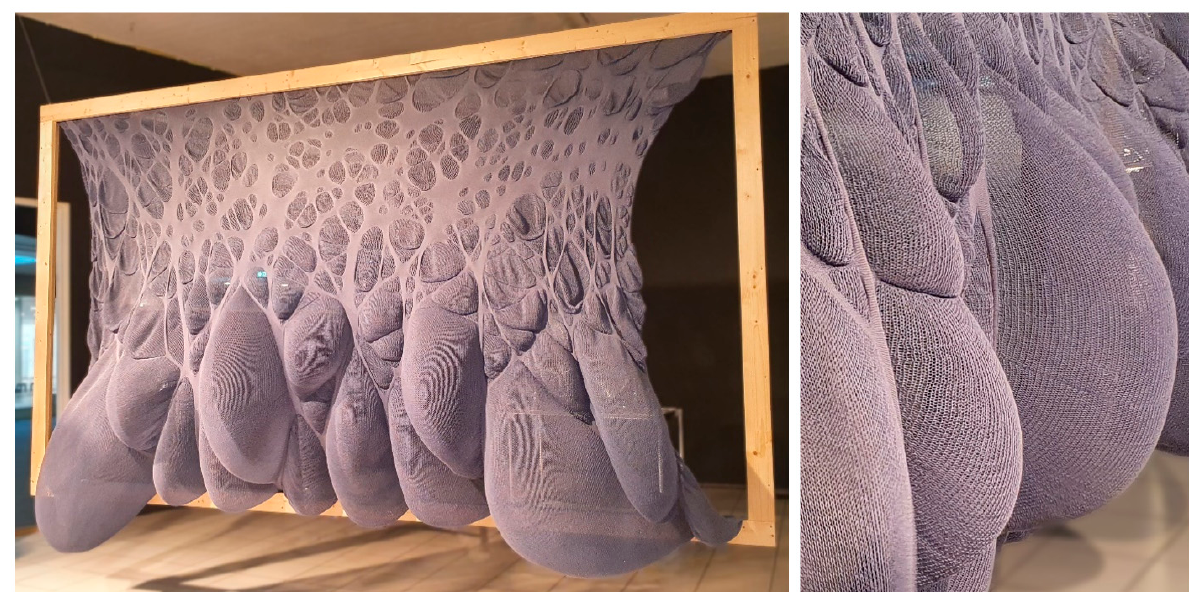
Figure 2. (in)Formed by Wind , by Erica Hörteborn. A large three-dimensional screen knitted with the drop-stitch technique. (Photo from the exhibition In Motion, at Sergels torg, Stockholm 2022.)